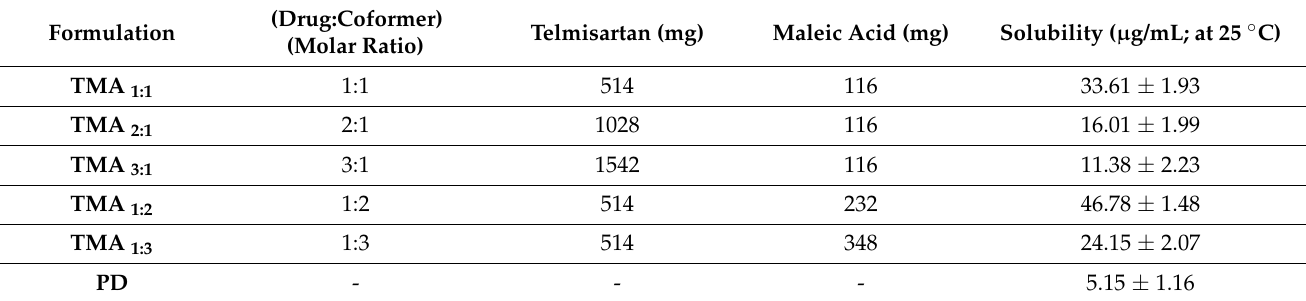
Table 1. Formulation and physico-chemical characterization of telmisartan-maleic acid